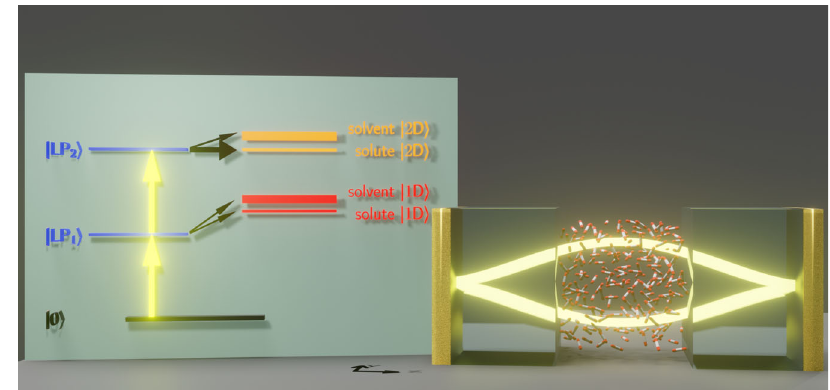
Fig. 1 Sketch of the cavity setup for CavMD simulations. N sub molecules are con fi ned in a cavity formed by a pair of parallel metallic mirrors. These molecules are coupled to a single cavity mode (with two polarization directions) and are simulated in a periodic simulation cell. Our classical CavMD simulations show that, after a strong excitation of the solvent lower polariton (LP) with an IR laser pulse, the input energy can be selectively transferred to the highly excited dark states of the solute molecules, leaving the vast majority of the solvent molecules barely excited. The left cartoon demonstrates the quantum analog of our classical fi nding; see Supplementary Note 8 for